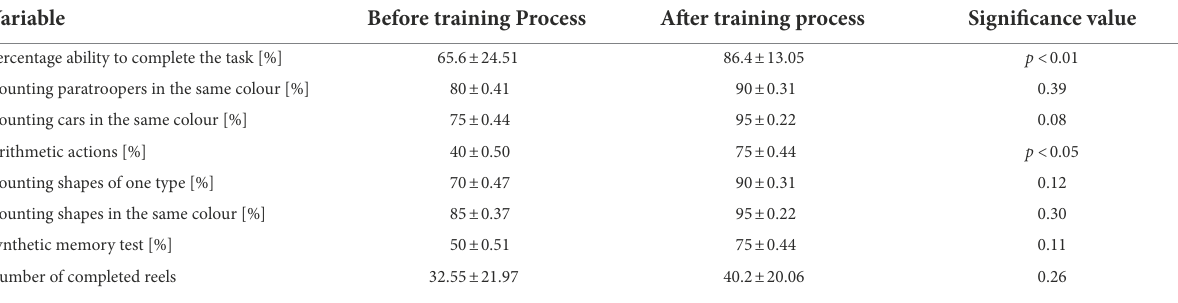
TABLE 6 Percentage ability to complete all tasks during the forward reels before and after the training process in cadet pilots.